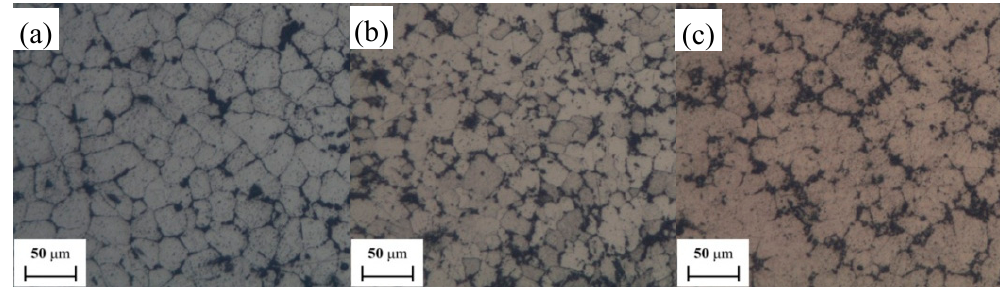
Figure 8. Microstructures of specimens after rheocasting using a triple-bend serpentuator and heat treatment: ( a ) 3.0 wt. % TiB 2 /7075, ( b ) 4.5 wt. % TiB 2 /7075, ( c ) 6.0 wt. % TiB 2 /7075.